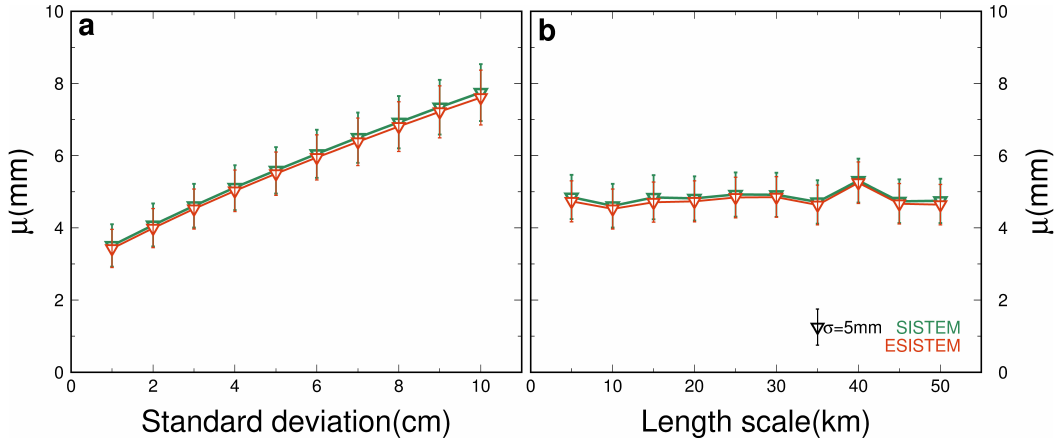
Figure 6. Sensitivities of SISTEM and ESISTEM approaches to: ( a ) standard deviation of InSAR noises; and ( b ) length